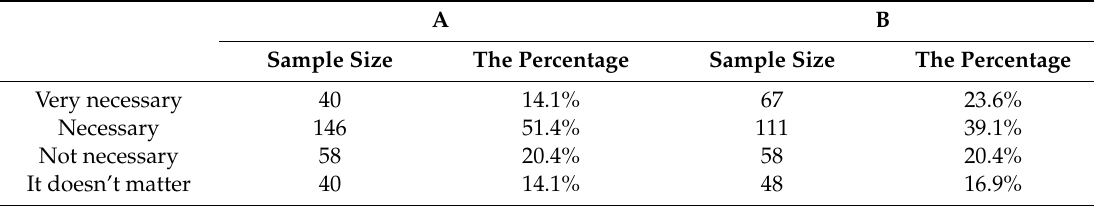
Table 3. Farmers’ views on the need for centralized management of vacant homesteads and whether the current system needs to be